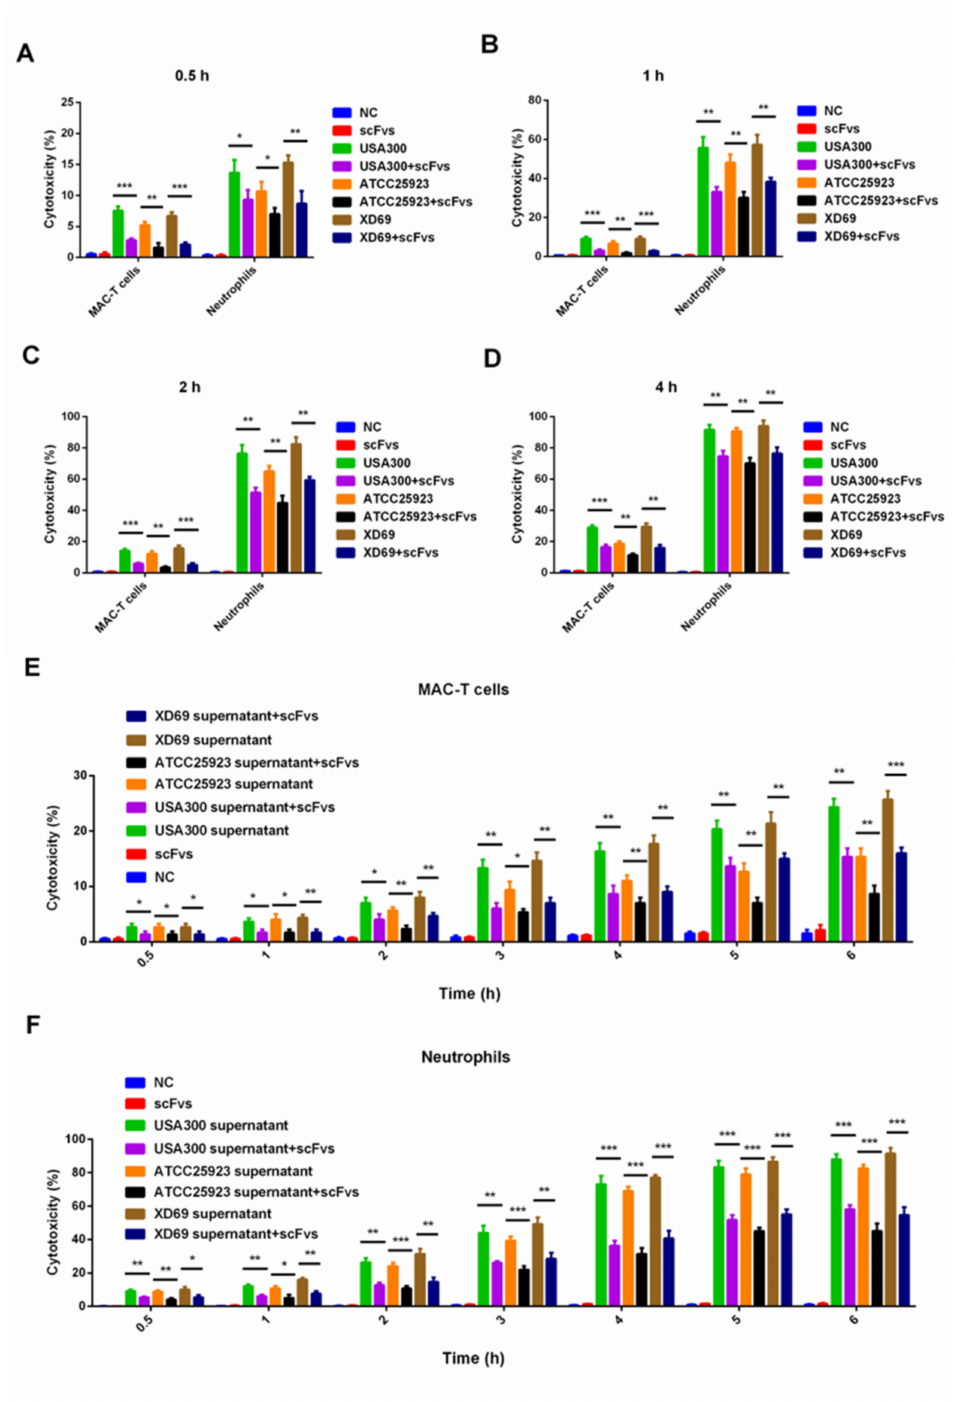
Figure 5. The cell killing of bovine neutrophils and MAC-T cells. ( A – D ) The LDH release of bovine neutrophils and MAC-T cells infected by three strains (USA300, ATCC25923 and XD69) over time. ( E , F ) The LDH release of bovine neutrophils and MAC-T cells infected by the supernatant of three strains over time. Data represent the mean results ± SD ( n = 3) (ns = p > 0.05, * p < 0.05, ** p < 0.01, *** p <